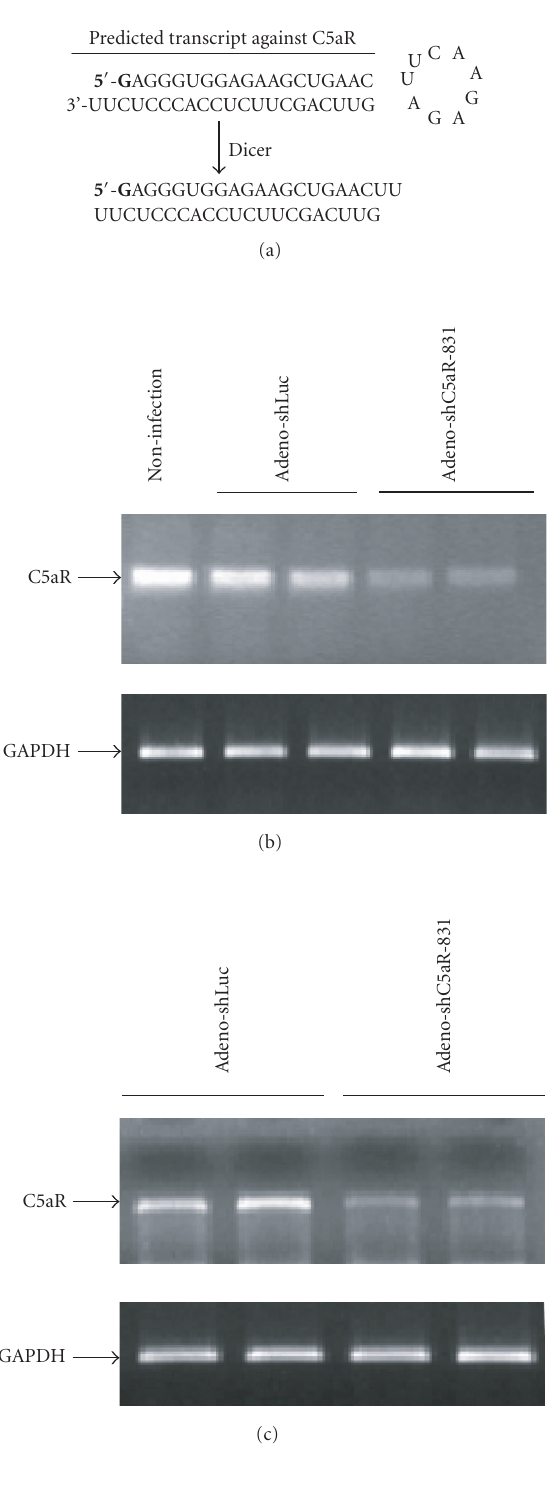
Figure 5: In vivo silencing by adenovirus delivey of siRNA. (a) The predicted shRNA transcript from the adenovirus vector and the expected Dicer processing products in vivo. Semiquantitative RT-PCR analysis with whole lung RNAs from control (b) and sep- tic mice (c) showed the decreased C5aR expression in mice in- fected with C5aR-siRNA adenovirus. Luciferase-siRNA-adenovirus infected lungs were used as